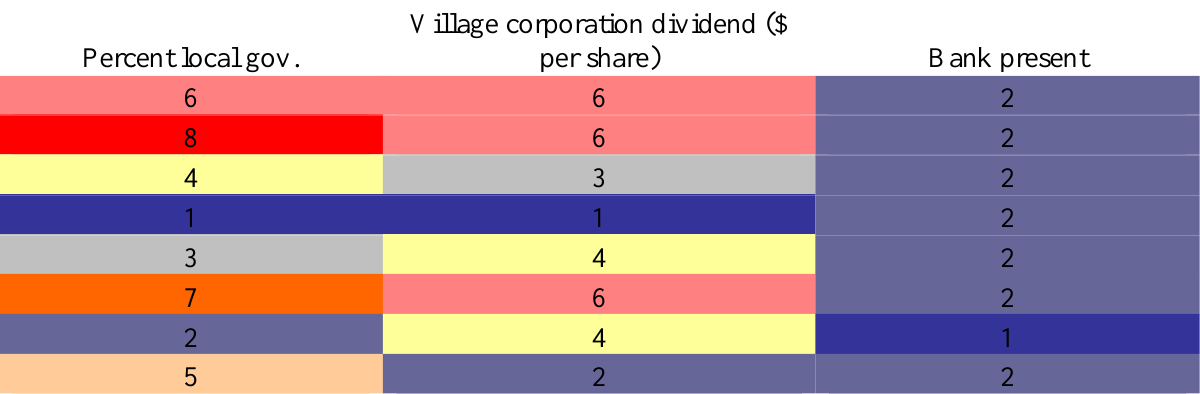
Table A2.12 Financial capital – rank